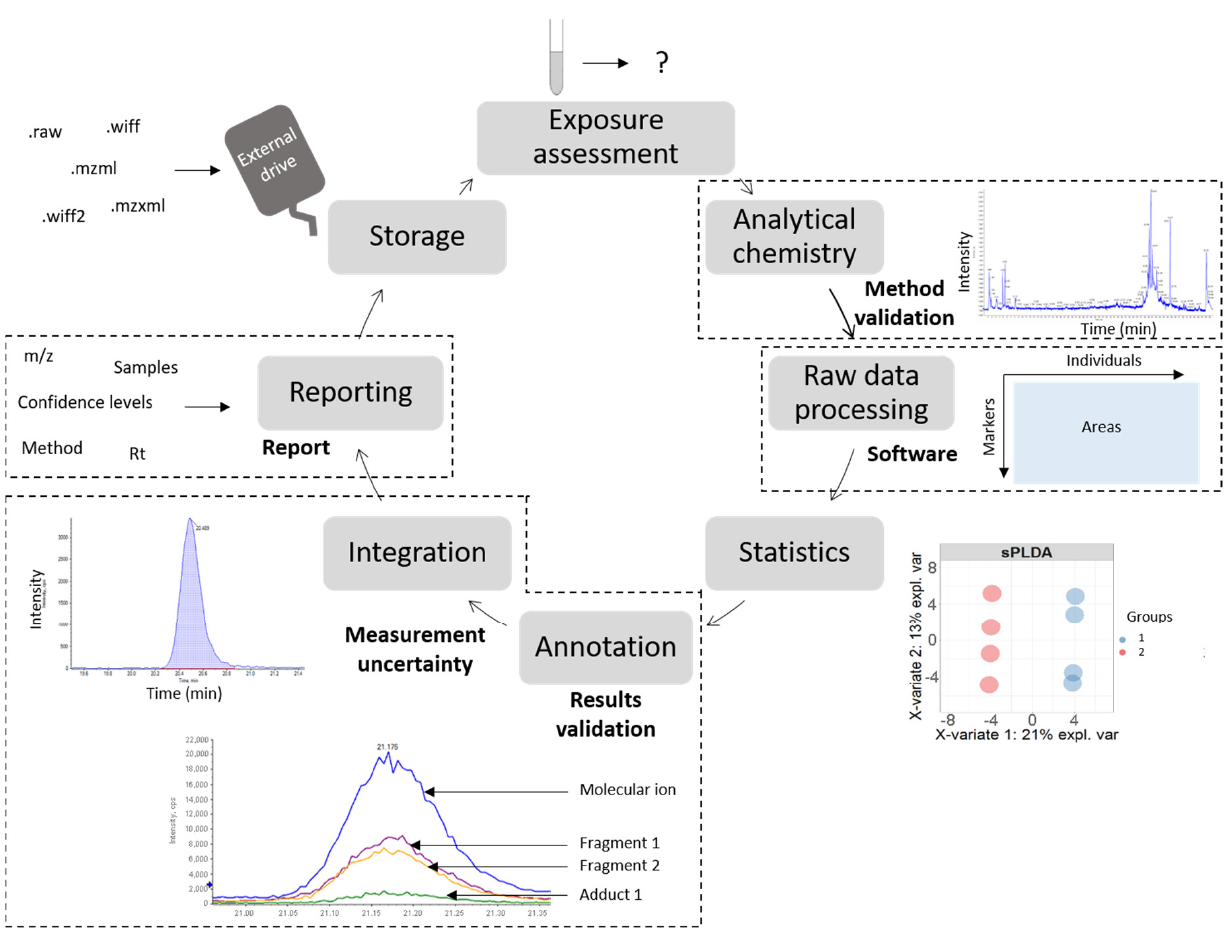
Figure 1. Steps of the non-targeted workflow requiring harmonization in order to be adapted for the ISO/IEC 17025:2017 quality standard (circled in dashed black lines). These steps are further discussed in the paragraphs indicated circled in orange solid lines.